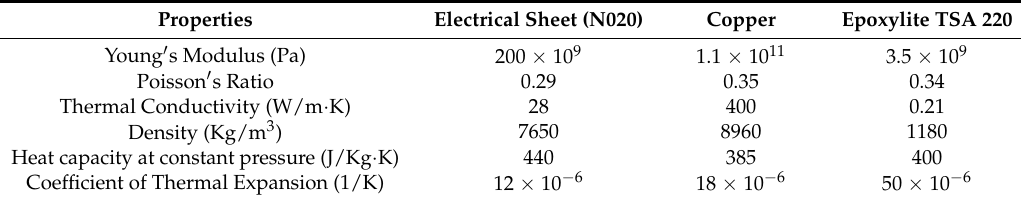
Table 2. Thermal and mechanical properties of the materials.